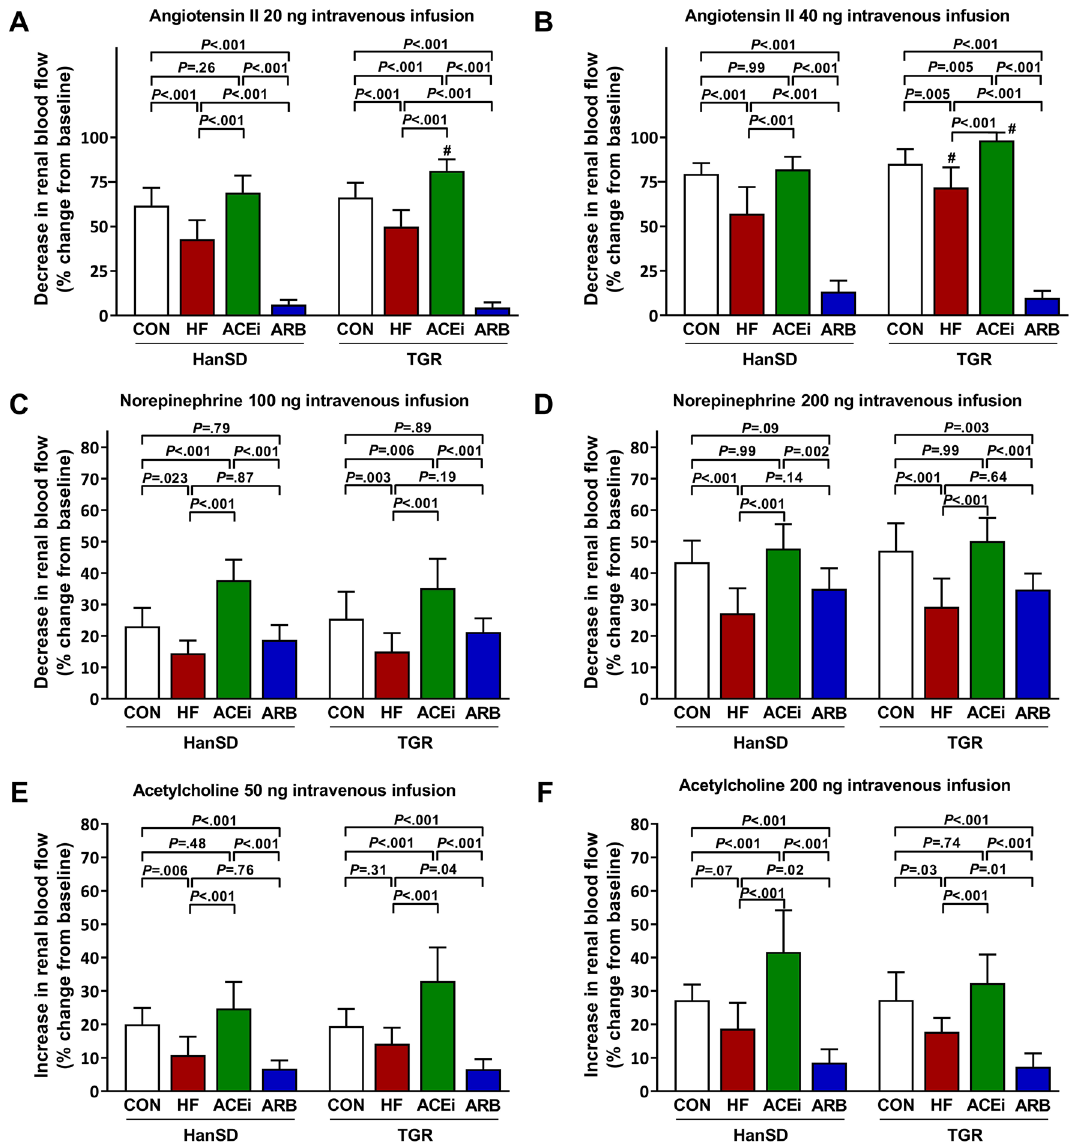
Figure 4. Maximum changes in renal blood flow elicited by intravenous boluses of angiotensin II 20 ng ( A ), angiotensin II 40 ng ( B ), norepinephrine 100 ng ( C ), norepinephrine 200 ng ( D ), acetylcholine 50 ng ( E ) and acetylcholine 200 ng ( F ) of control (CON), untreated heart failure (HF), ACE inhibitor-treated (ACEi) and AT 1 receptor blocker-treated (ARB) HanSD and TGR rats 20 weeks after sham or ACF operation (5 weeks in HF TGR rats due to high mortality). Data presented as mean ± SD (n = 10 in each group). # P < 0.05 compared to HanSD